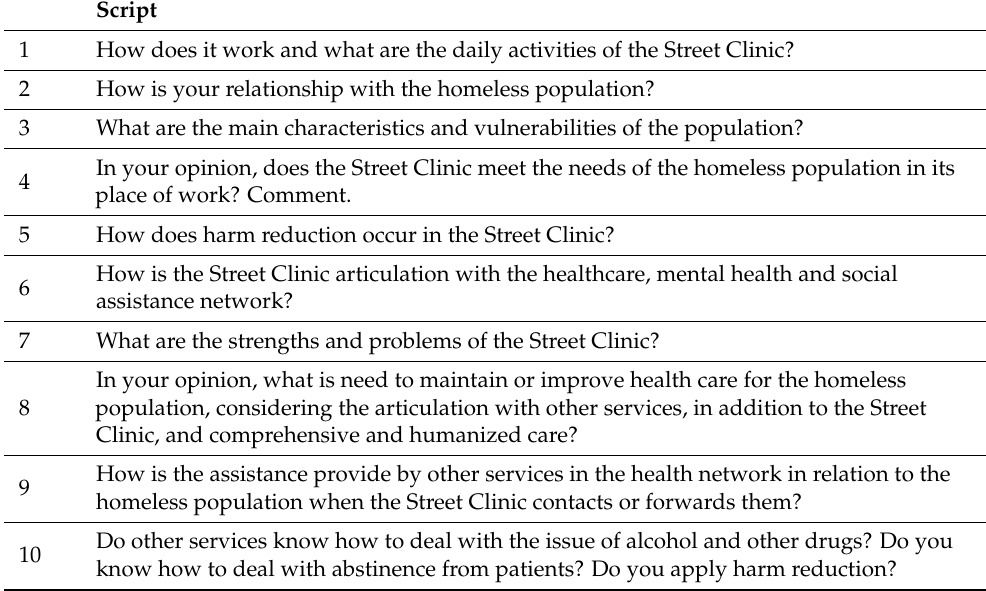
Table 2. The semi-structured interview instrument. Brazil,